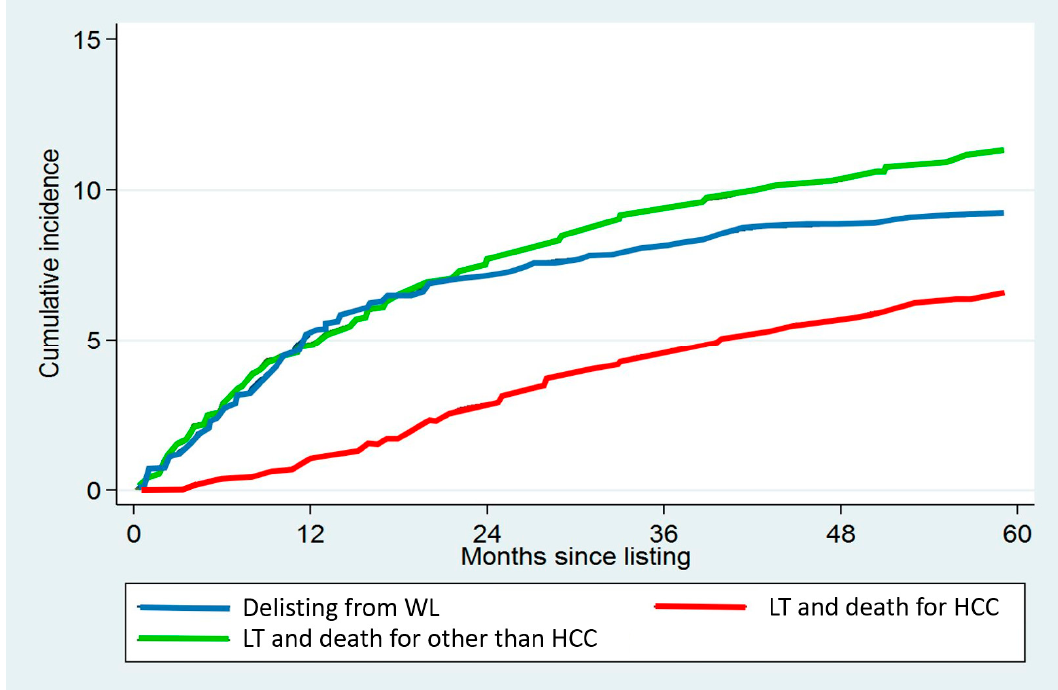
Figure 1. Cumulative incidences of delisting, of receiving LT and dying for HCC, and of receiving LT and dying for other causes, in the entire study population of 3091 patients.